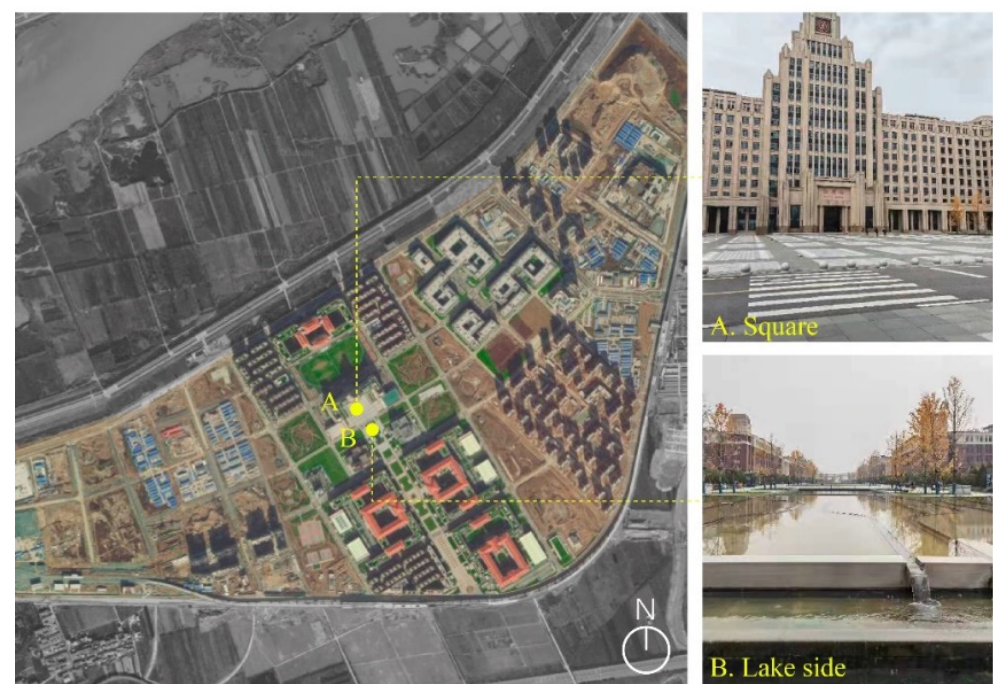
Figure 2. Research site and the test locations. ( A ) Square, ( B ) Lake side. Table 1. Features of outdoor physical spaces at each site.